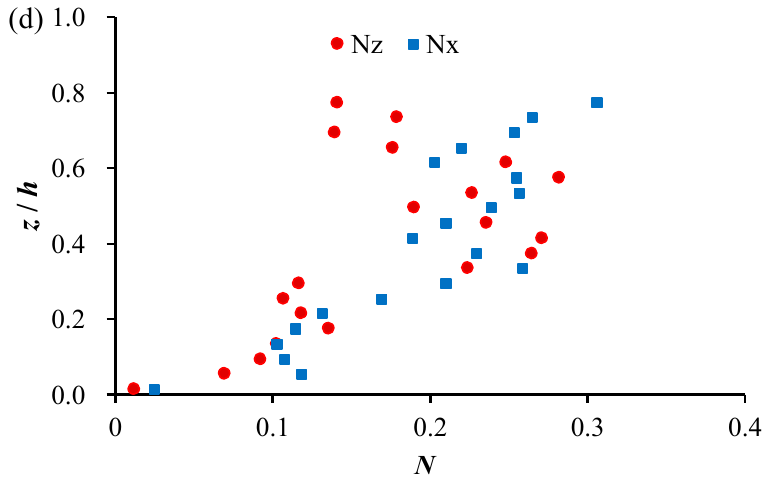
Figure 10. Vertical distribution of turbulence intensity along the streamwise center line: ( a ) x = − 0.35 m, ( b ) x = 0.05 m, ( c ) x = 0.25 m, ( d ) x = 0.75 m.